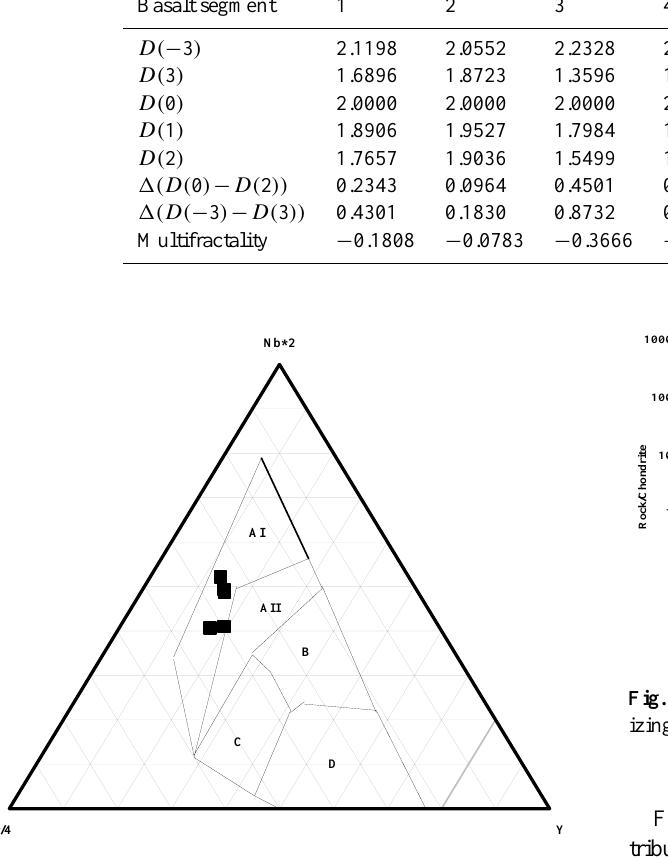
Fig. 5 . Chondrite-normalized REE distribution patterns (Normalizing values from Sun and Mc Donough(1989)) Fig. 5 does show th s. It can be seen that all e Chondrite-normalized REE distribution pattern amples show slightly sloping chondrite-normalized REE patterns, rich in light rare earth the s elements (LREE, La-Sm) but depleted in heavy rare earth elements (HREE, Eu-Lu), with ((La) N /(Yb) N values ranging from 7.1 to 21.5. Samples 201-4 and 201-11 have weakly negative Eu anomalies. The REE distribution patterns of samples 201-3 and 201-4 are similar to each other and their total REE contents are 1883.38ppb and 1973.74ppb, respectively, and higher than those of other samples raging from 118.17 to167.92ppb.